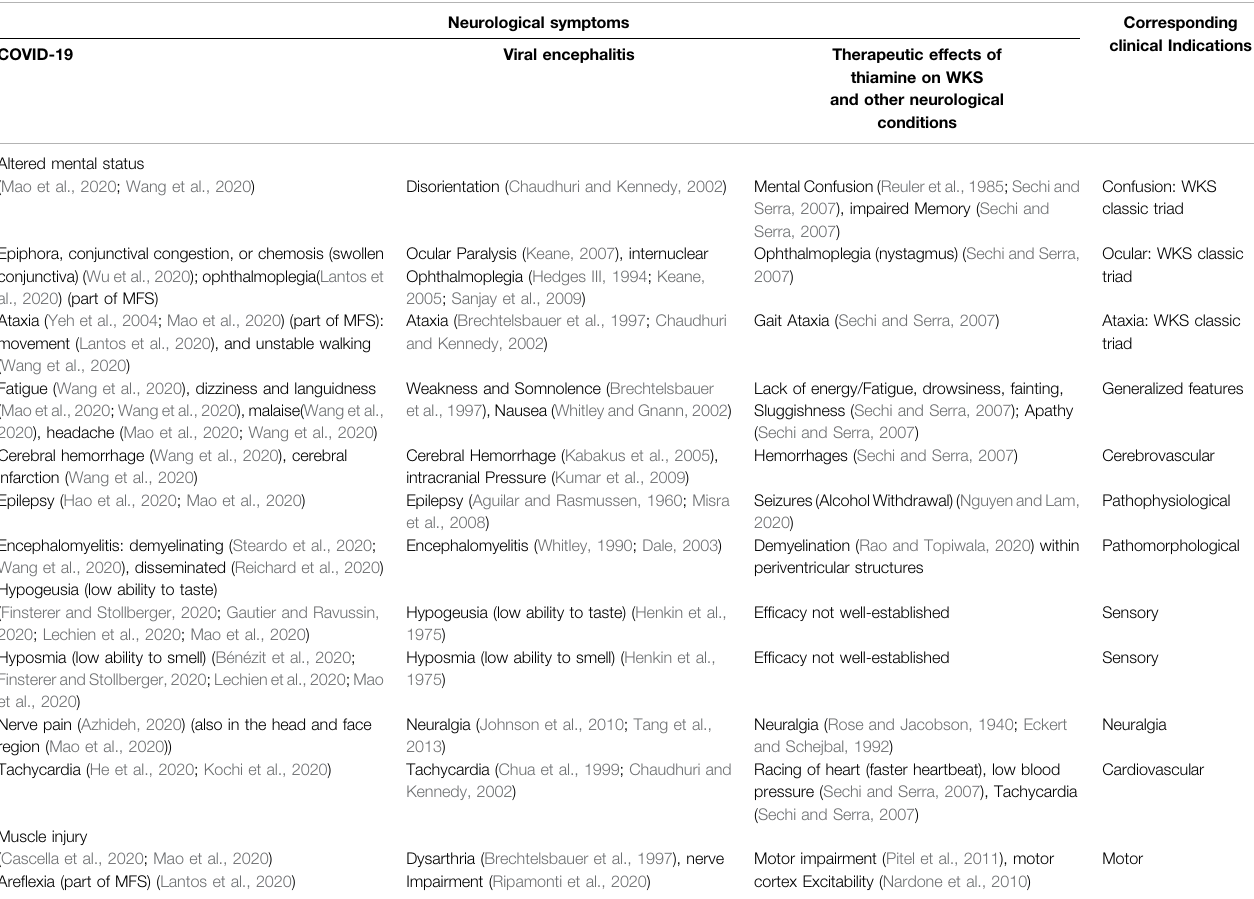
TABLE 1 | Neurological symptoms in COVID-19, Viral Encephalitis (Grouped/assorted by the neurological spectrum observed in COVID-19), showing their proximity in presentation.